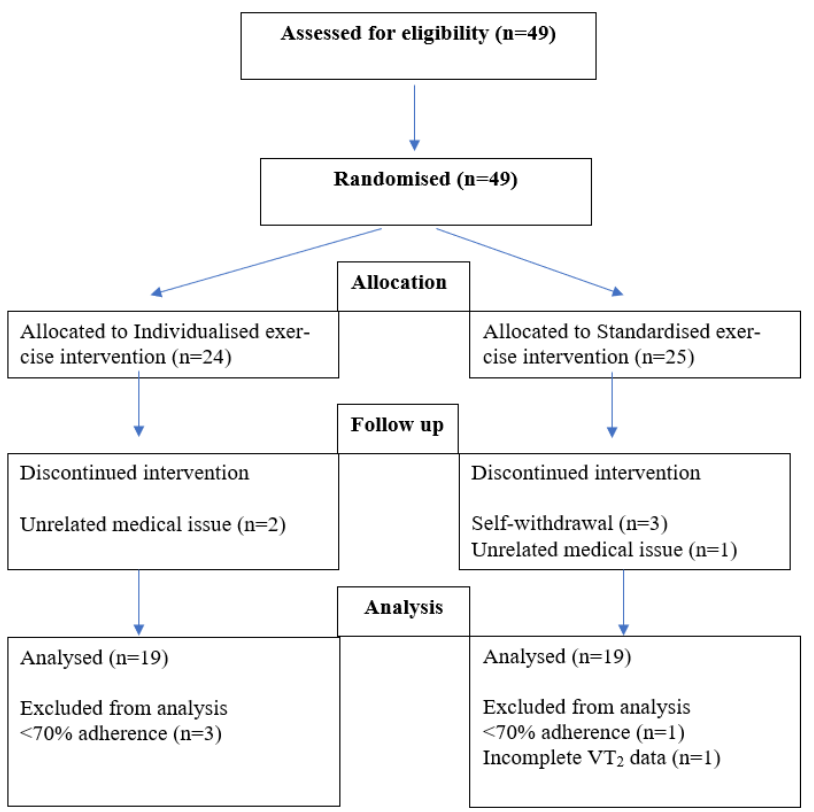
Figure 2. Number of participants recruited and rationale for data analysis exclusion. Mean pre-and post-exercise intervention parameter characteristics are presented in Table 1. A significant between group difference in VO 2 max was noted at baseline. The